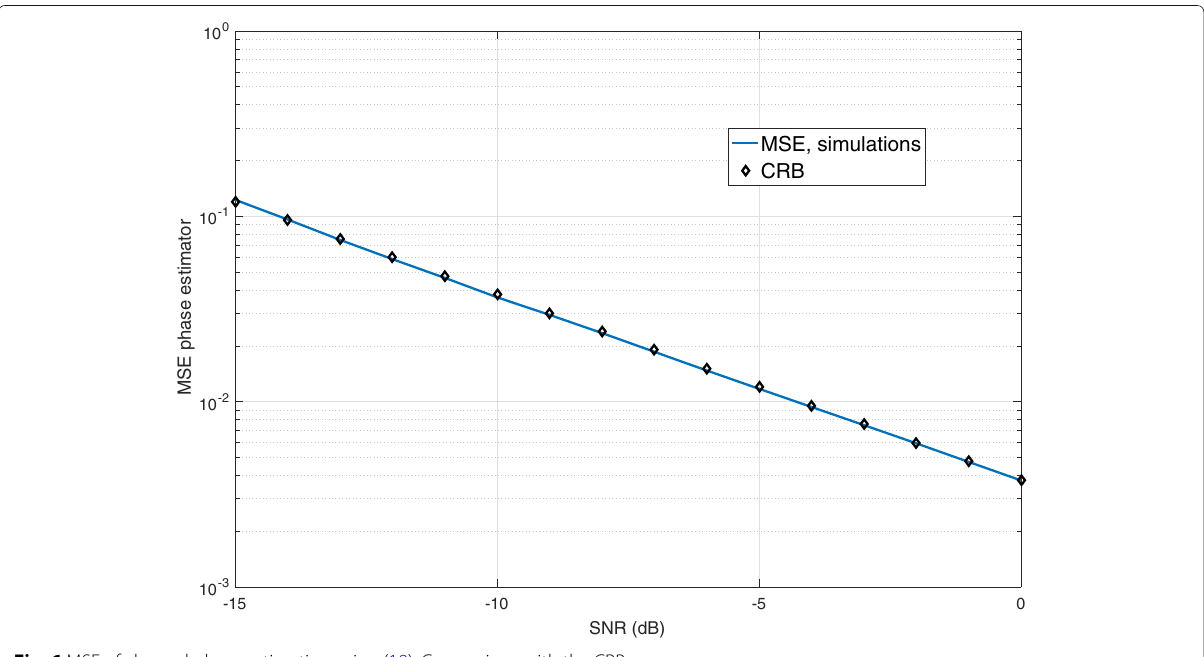
Fig. 6 MSE of channel phase estimation using (18). Comparison with the CRB